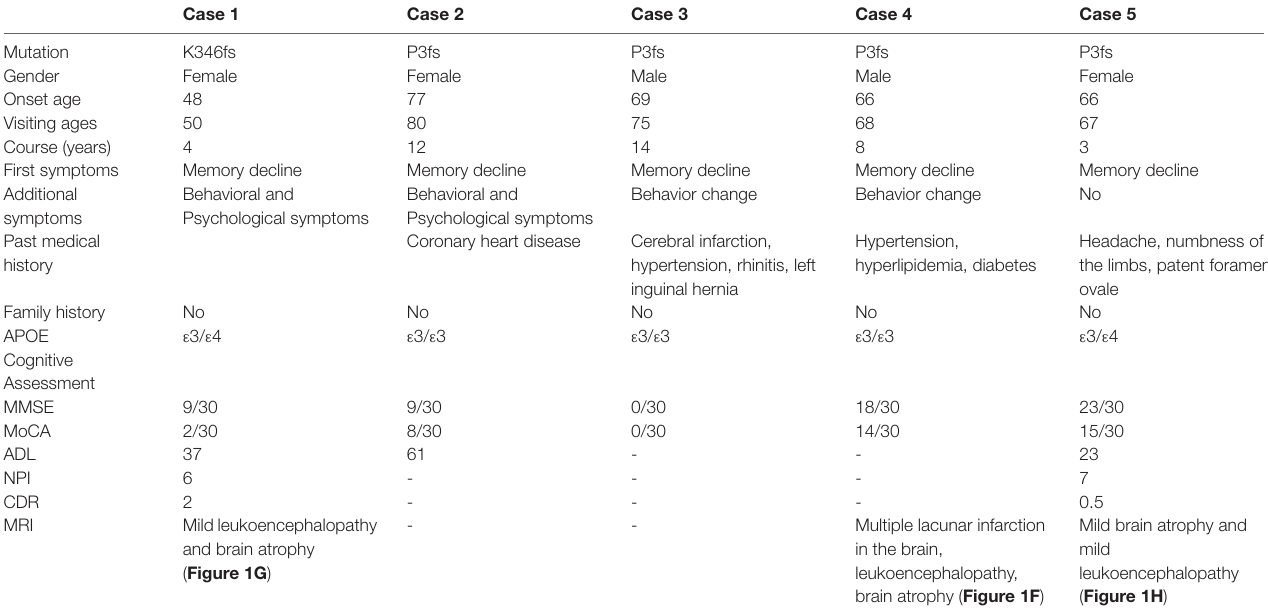
TABLE 3 | Information of five patients with mutations in the GSN